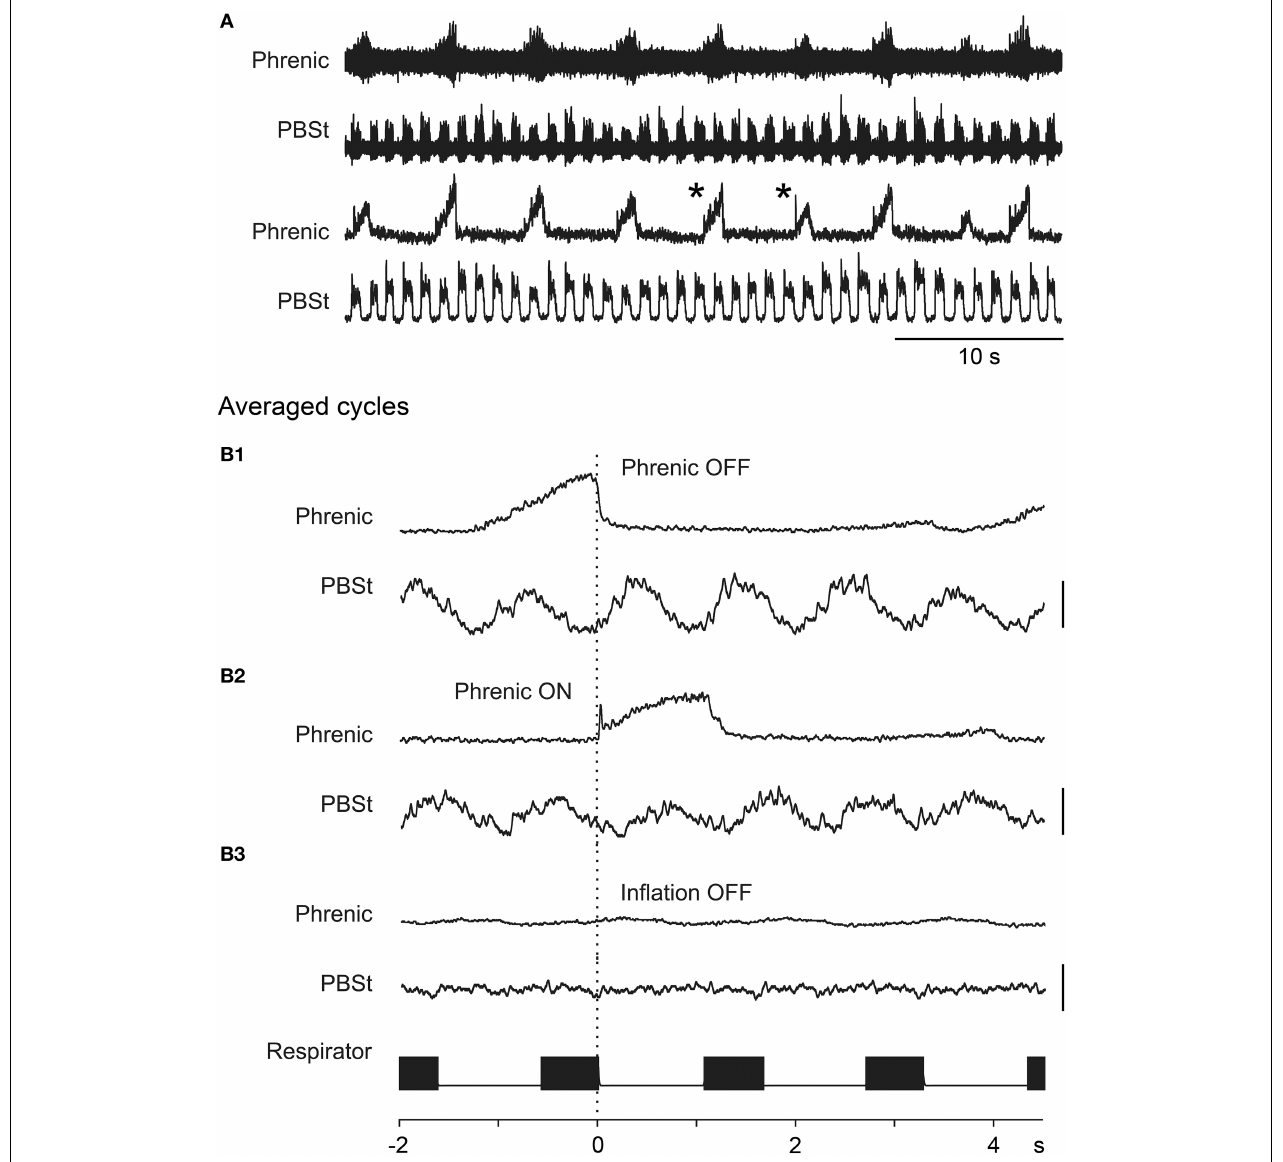
FIGURE 6 | Entrainment of the locomotor rhythm by the phrenic nerve discharge. (A) A segment of spontaneous ENG discharges in the phrenic and PBSt nerves. The lower two traces show the integrated rectified versions of the upper two traces. In (B1–B3) are shown the discharge in the PBSt nerve where the cycles were averaged in relation to the offset of the phrenic nerve burst (B1) , the onset of the phrenic nerve burst (B2) , and the offset of the inflation phase of the artificial respiration (B3) . The respirator signal was derived from a record of the opening of the inflation valve on this device